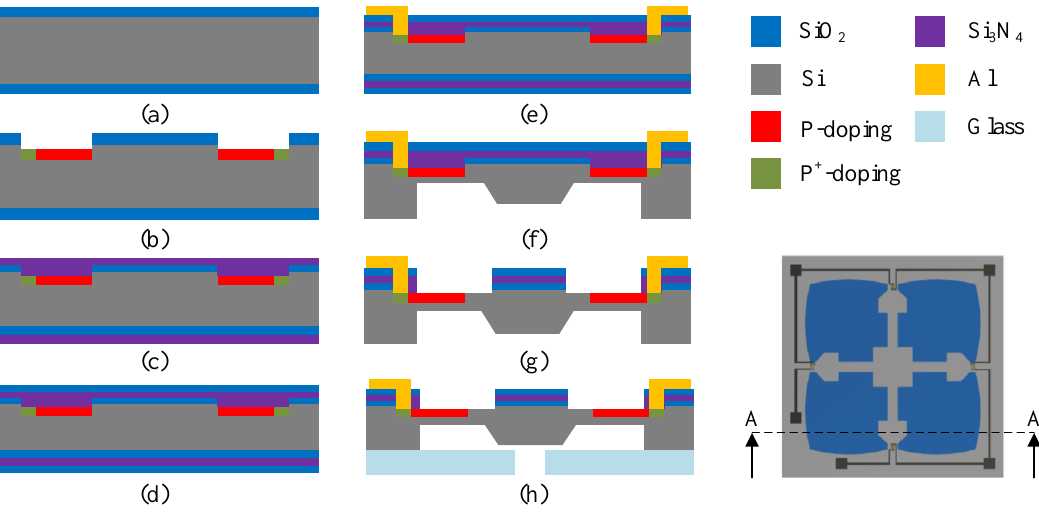
Figure 10. ( a – h ) Main fabrication process of the proposed sensor